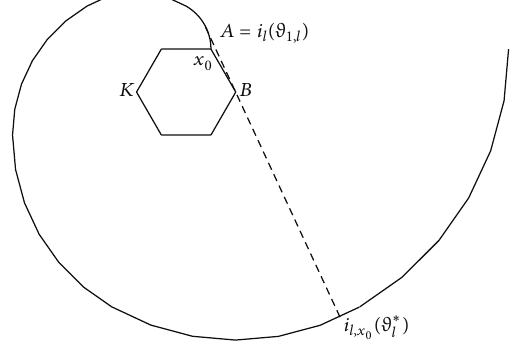
Figure 2: Left involute of an hexagon.